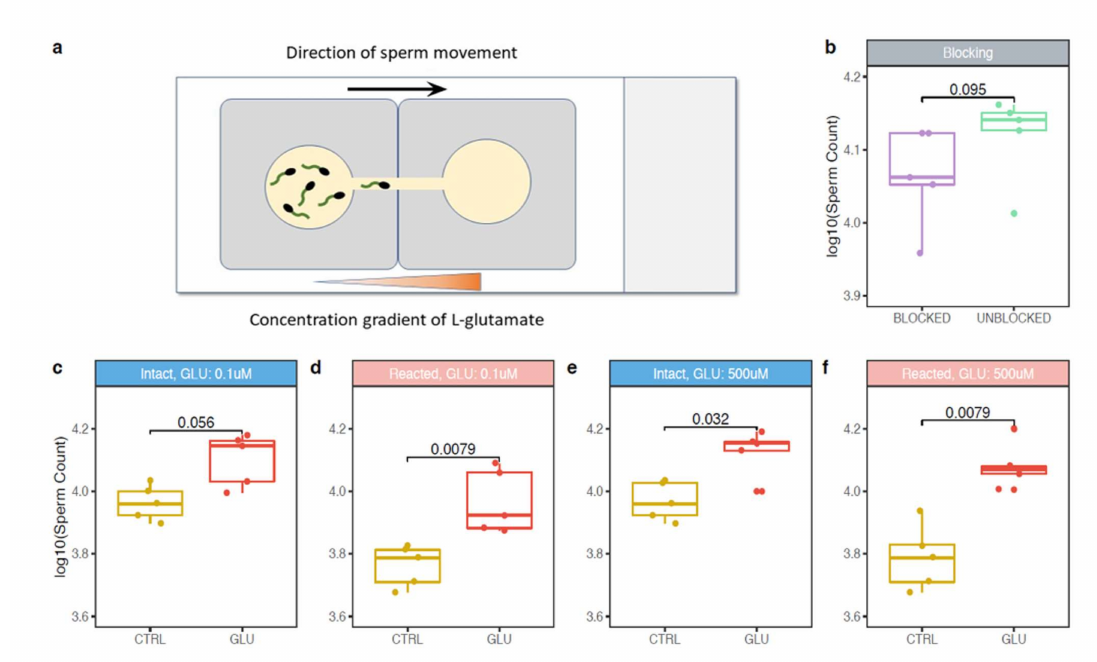
Figure 3. Sperm chemotactic response to L-glutamate . ( a ) Special chemotactic chamber was developed for assessing sperm attraction to L-glutamate . Wells were filled with M2 medium containing spermatozoa (left) and with L-glutamate (right) and connected through the bridge. The black arrow represents the direction of sperm movement, whereas the orange triangle represents the concentration gradient of L-glutamate. SecureSeal imaging spacers are in grey. ( b ) Comparison of chemotactic response of acrosome-reacted sperm to L-glutamate in the presence or absence of a specific goat polyclonal anti-mouse mTAS1R3 antibody, n male = 5. The response to ( c,e ) acrosome-intact and ( d,f ) acrosome-reacted sperm to L-glutamate was analyzed in ( c,d ) 0.1 µ M and ( e,f ) 500 µ M